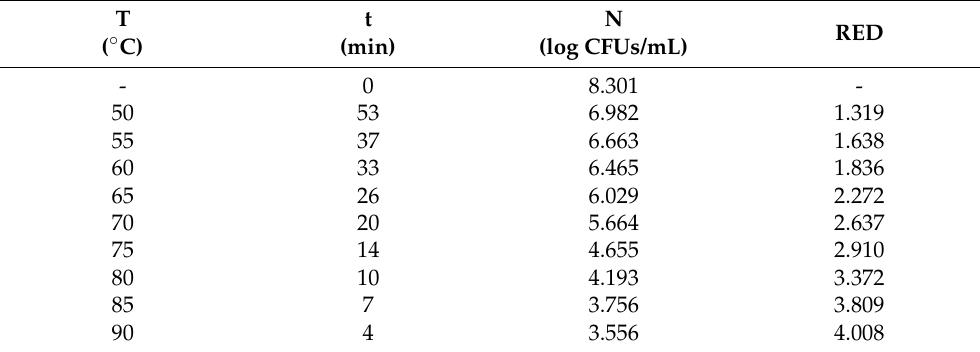
Table 2. Influence of photothermal treatment on the survival of S. aureus on textile